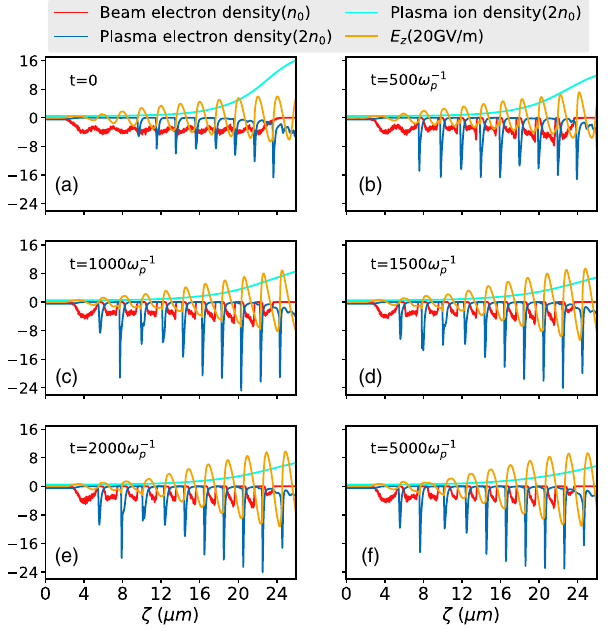
FIG. 8. Self-modulation regime ( B ¼ 0 . 11 ); the axial longi- tudinal electric fields (yellow), beam densities (red), and plasma densities (blue) are shown at times (a) 0, (b) 500 = ω p , (c) 1000 = ω p , (d) 1500 = ω p , (e) 2000 = ω p , and (f) 5000 = ω p . Initially, plasma electrons are unable to form voids in the beam (a). As the beam propagates, the self-modulation instability forms these voids (e) and resonance is maintained for a long duration (f). Notice, the amplification of the electric fields and the backward shift of the plasma wake